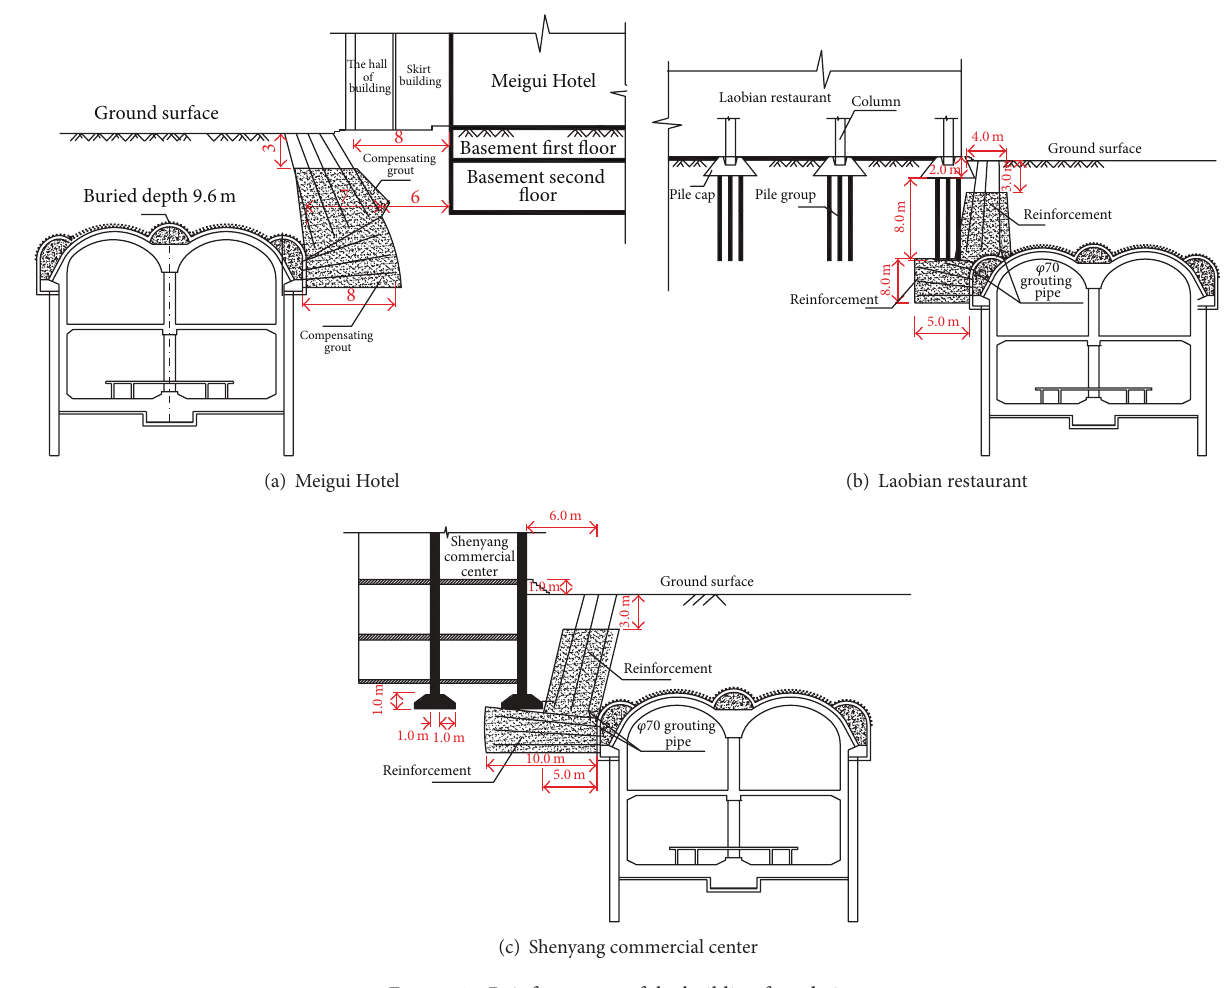
Figure 15: Reinforcement of the building foundation.